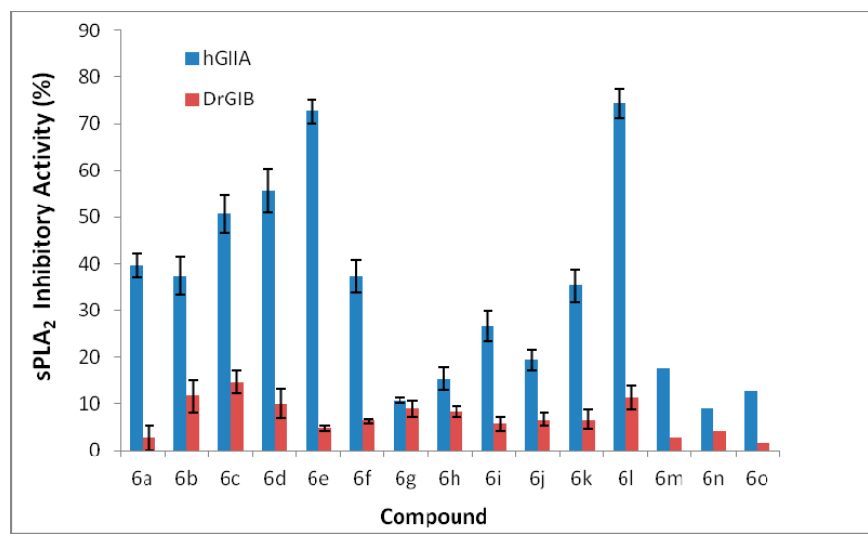
Figure 1. Inhibitory activity (%) of compounds 6a – o against sPLA 2 (hG-IIA and DrG-IB).